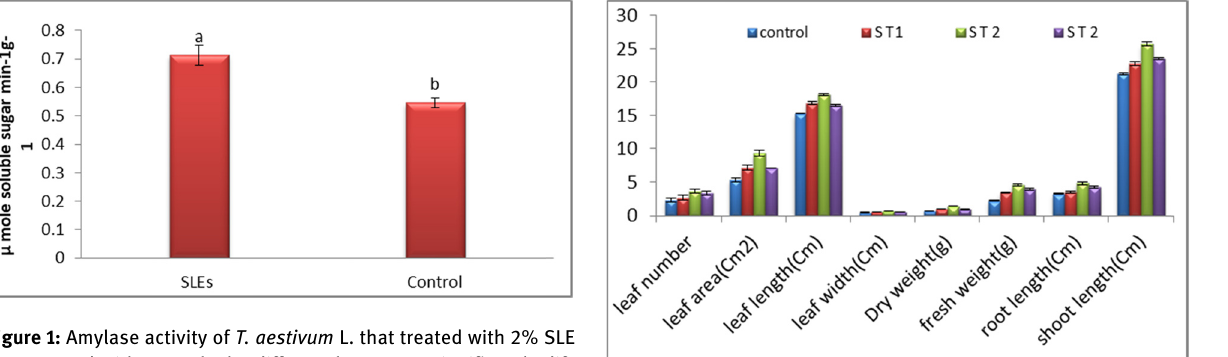
Figure 1: Amylase activity of T. aestivum L. that treated with 2% SLE is compared with control. The di ff erent letters are signi fi cantly dif - ferent ( P ≤ 0.05 ) according to Duncan ’ s multiple range tests.